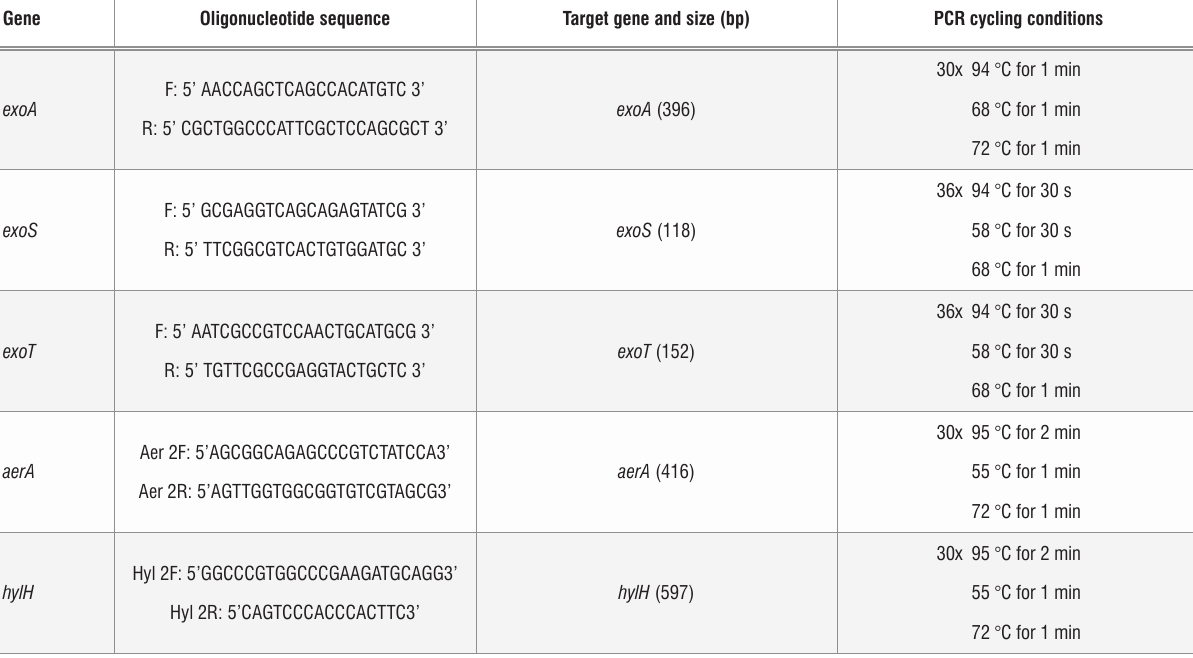
Table 2: Oligonucleotide primers used to detect virulence genes in Pseudomonas and Aeromonas species Gene Oligonucleotide sequence Target gene and size (bp) PCR cycling